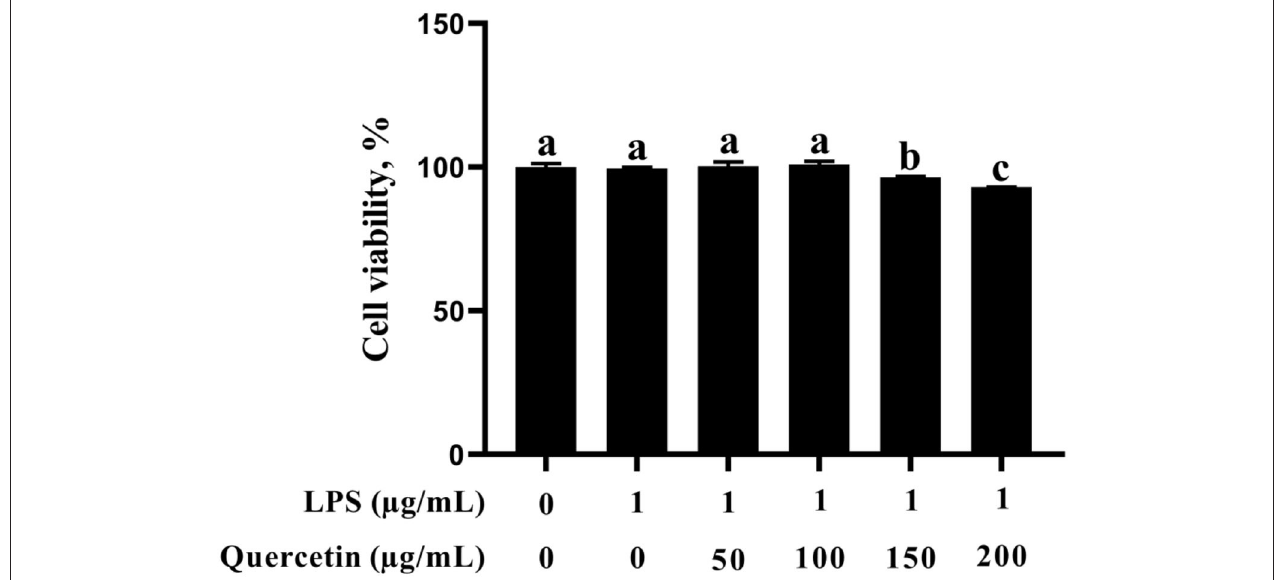
FIGURE 1 | Effects of quercetin on cell viability in lipopolysaccharide (LPS)-induced bovine mammary epithelial cells (BMECs). BMECs were treated with 1 µ g/ml of LPS and different concentrations of quercetin (50, 100, 150, or 200 µ g/ml) for 6h. The data from the control group were used to normalize the data of each treatment group. Data presented are mean ± SEM ( n = 4). Different lowercase letters in the bar chart indicate significant differences ( P <